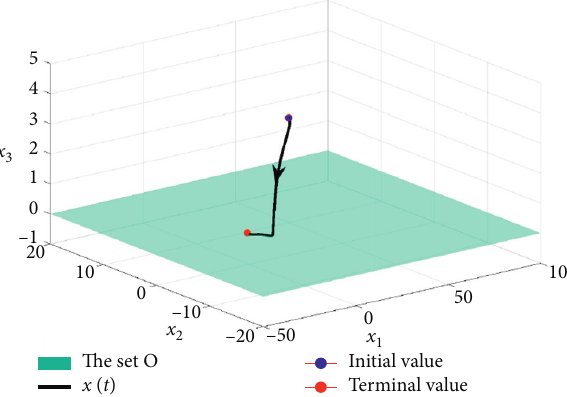
Figure 3: Simulation results of states for system